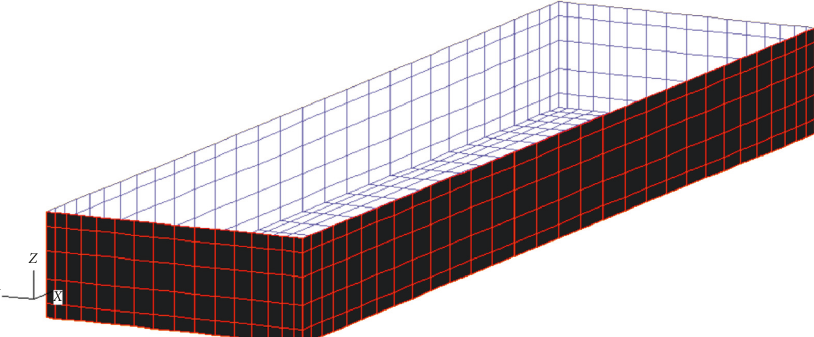
Figure 2: Numerical model of rectangular tank.